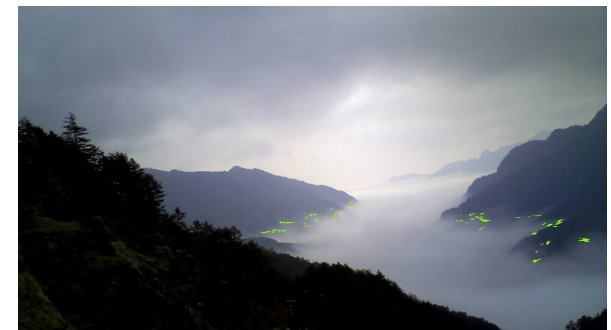
Figure 9. Cloud tops (green) detected in the scene taken on 19 March 2013 from 10:12 to 10:16UTC +